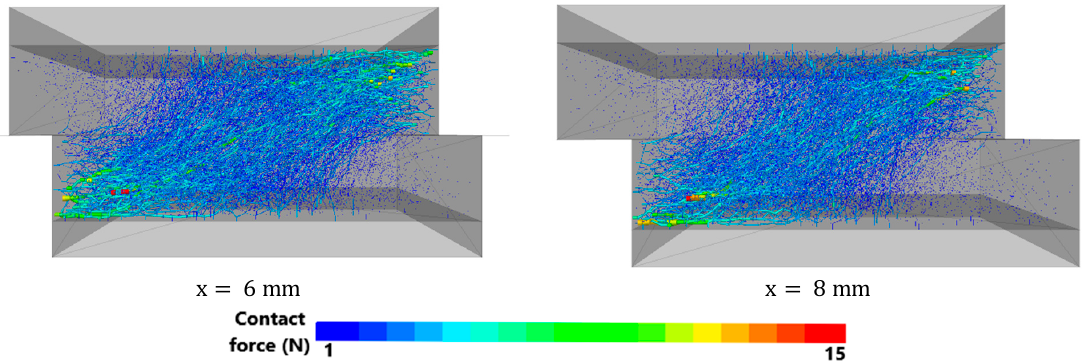
Figure 6. Distribution of contact forces (projection of all contact forces) drawn at the same scale for sample sheared under σ (cid:2924) (cid:3404) 160 kPa to different distances ( x (cid:3404) 0 (cid:3398) 8mm ).